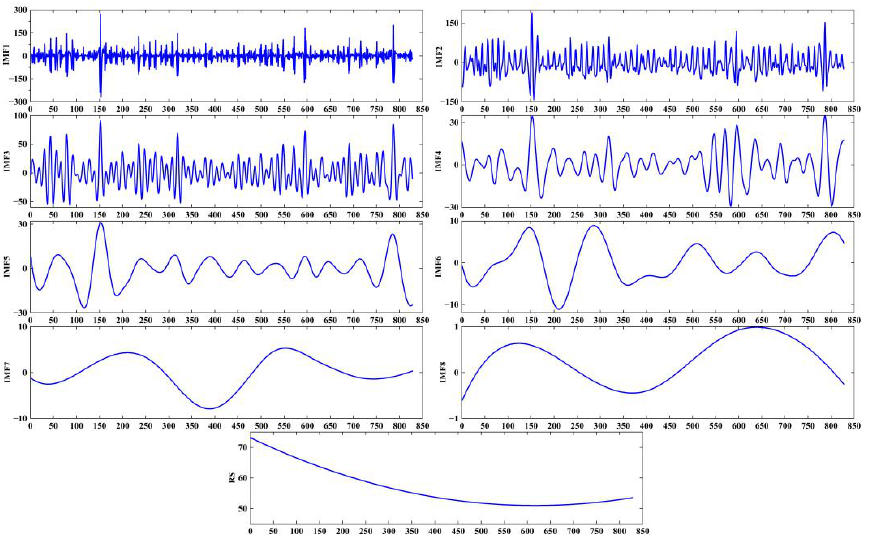
Figure 6. Precipitation CEEMD decomposition in Zhengzhou from 1951 to 2019.